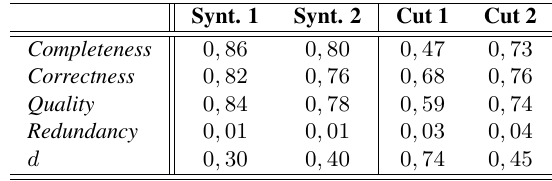
Table 1: Performance measures of the road extraction